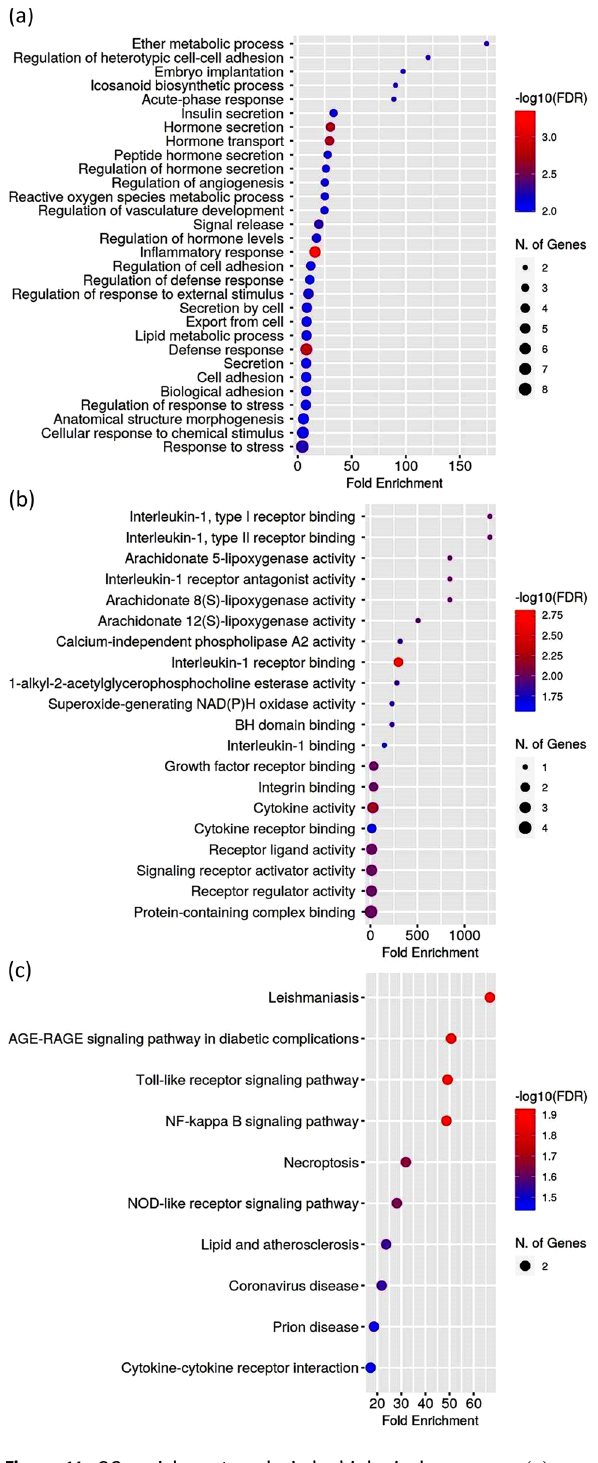
Figure 14: GO enrichment analysis by biological processes ( a ) , molecular functions ( b ) , KEGG pathways ( c ) for upregulated hub genes from the GSE5058, GSE11784, GSE11906, and GSE100927 datasets. Biological processes, molecular functions, and KEGG pathways are ranked according to fold enrichment values. The most signi fi cant processes are highlighted in red, and the less signi fi cant processes in blue according to log10 ( FDR ) values. Larger dots in the graph indicate a greater number of genes